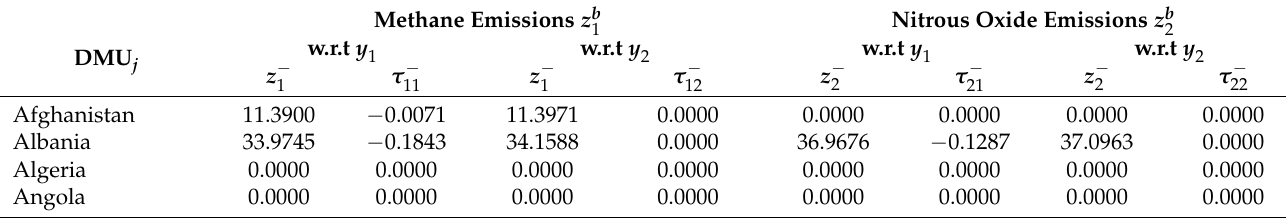
) and nitrous oxide ( z b 1